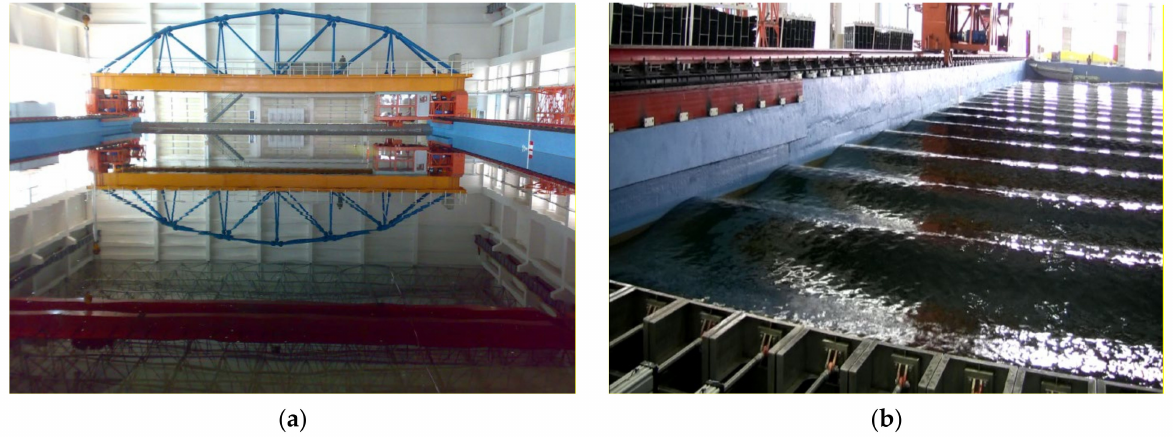
Figure 13. Towing tank and its wave-making equipment. ( a ) Towing tank at Harbin Engineering University. ( b ) Wave- making equipment in towing